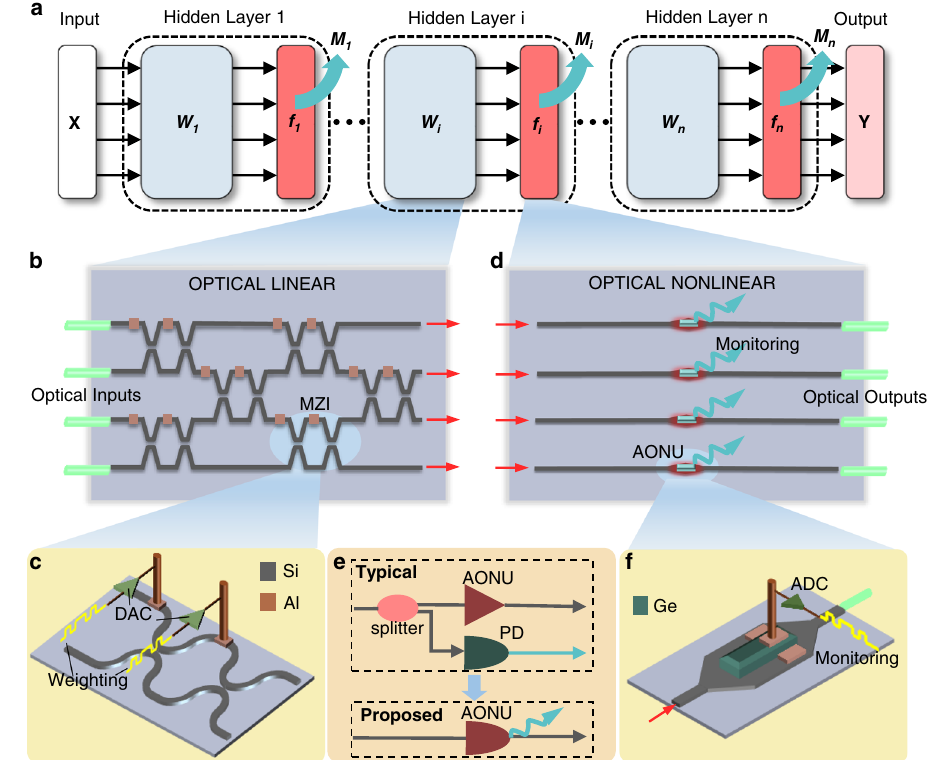
fi gure shows the rectangular mesh connected by 6 MZIs, equivalent to any 4×4 unitary matrixes. c The detailed structure of a tunable Mach-Zehnder inter- ferometer.AnMZIconsistsoftwoopticalphaseshiftersandtwosplitters.Any2×2 unitarymatrixescanbecon fi gured.TheMZInetworkintegratedinaphotonicchip interconnects with the DAC through wire bonding. Al, aluminum. d The Ge-Si all- optical nonlinear block for optical nonlinear activation and electrical monitoring. Four AONUs are included. e From light-splitting-and-detection to non-intrusive monitoring. f The detailed structure of the AONU. The Ge fi lm coats on the Si waveguide and interacts with shows the false-color image of the fabricated AONU. A 4.3 × 8 μ m 2 Ge thin fi lm is epitaxially grown on the Si waveguide. The 3 μ m-length electrodes are coated at the optical exportation of Ge.